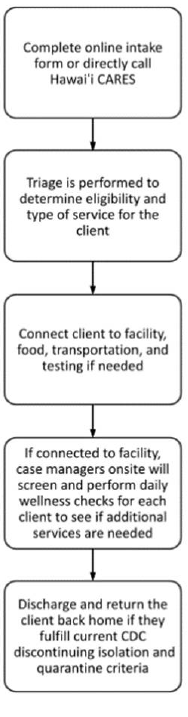
Figure 2. Workflow diagram summary of the key planning tasks of the Hawaii isolation and quar- antine system, 10 August 2020 to 30 September 2021. Notes: The isolation and quarantine system starts with the intake form. The triage team then connects them to the needed services accordingly.